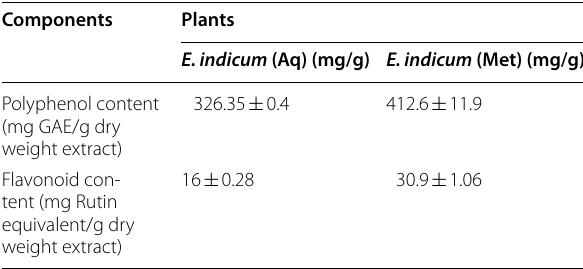
Table 2 Quantitative analysis of total flavonoid and polyphenol